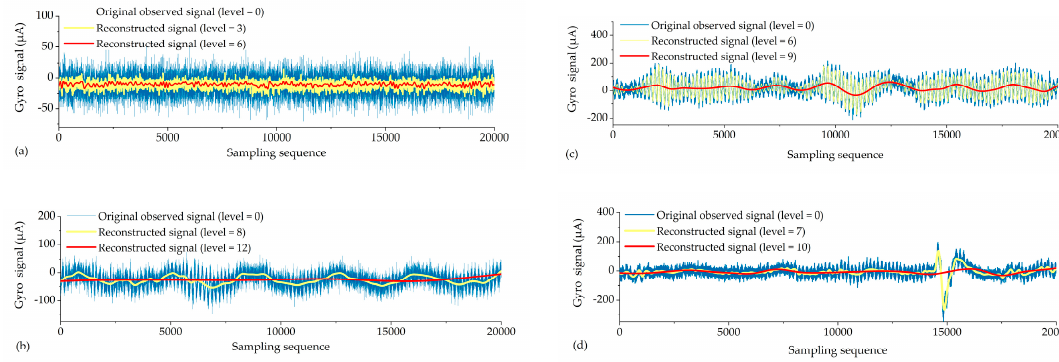
Sensors 2019 , x , x 11 of 17 Figure 7. Time series of reconstructed signals: ( a ) steady; ( b ) periodic; ( c ) jitter; ( d ) jumping.